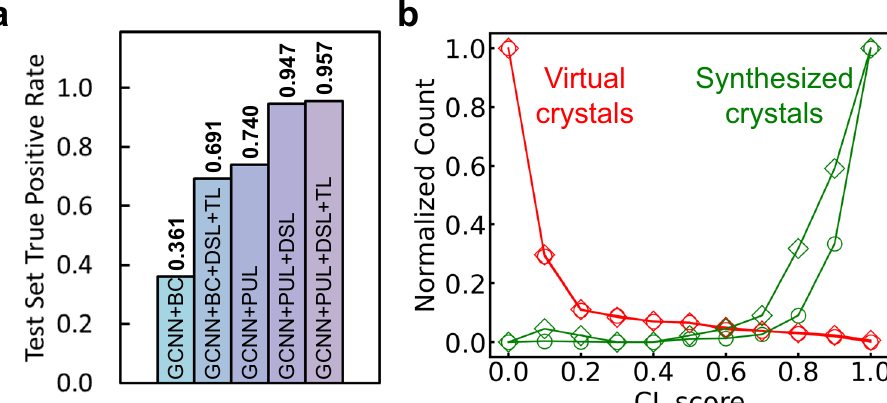
Fig. 2 Model accuracy and data distribution. a The out-of-sample true positive rate for perovskites for the various tested models. GCNN indicates graph convolutional network, BC indicates binary classi fi cation, PUL indicates positive-unlabeled learning, DSL indicates domain- speci fi c learning, and TL indicates transfer learning. True positive rate is assessed as the performance measure, as the positive data (synthesized crystals) are known, while the negative data (unsynthesizable crystals) are not known. As the unlabeled data (virtual crystals) are available in the database, positive unlabeled learning is implemented to assess synthesizability. b The score distribution for the synthesized and virtual crystals. Diamond and circle marks indicate the out-of-sample test data, and all data, respectively. The count is normalized by the highest peak